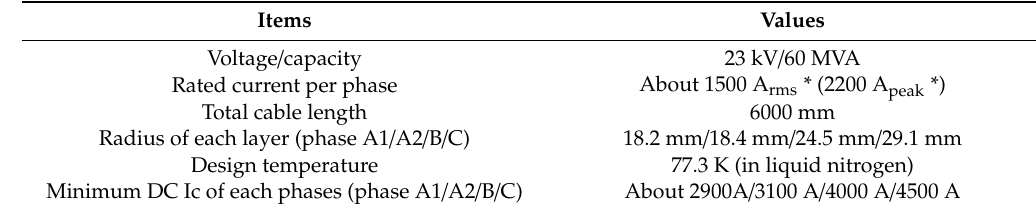
Table 2. Specifications of the tri-axial HTS power cable model.